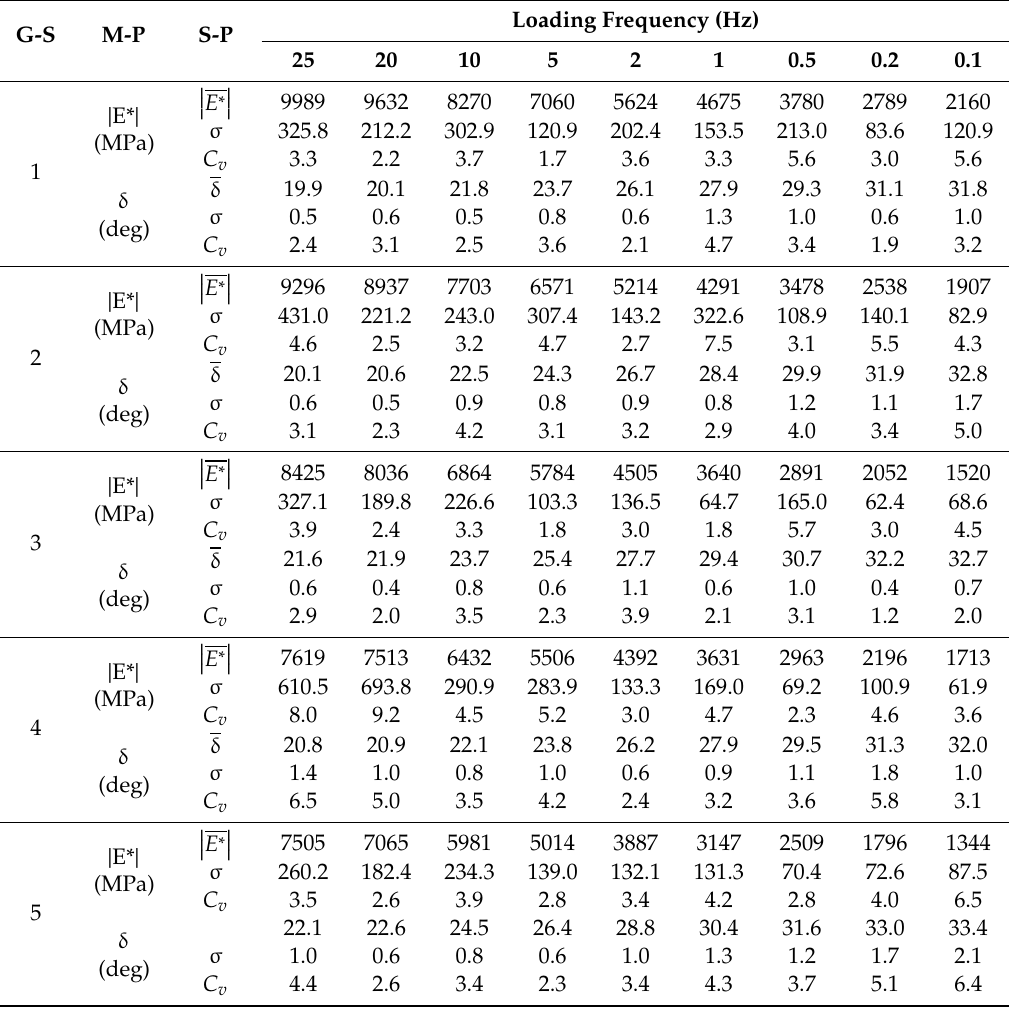
Table 4. The test results of the dynamic modulus and phase angle at 20 ◦